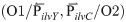
Schematic of the transcription regulation of the ilvY and ilvC genes.IlvY is the LysR-type transcriptional regulator designated in yellow. IlvY binds in a highly cooperative fashion to two tandem operator regions, O1 and O2, in the divergently overlapping ilvYC regulatory region designated (O1/P⃐ilvY,P⃑ilvC/O2). Upon binding to the first operator region, O1, the IlvY regulator negatively autoregulates transcription from the ilvY promoter, thus repressing its own further synthesis. Activation of ilvC transcription requires binding of the IlvY regulator to the second operator region, O2, and additional binding of a co-inducer such as 2-acetolactate (AL) or 2-aceto-2-hydroxybutanoate (AHB) to a preformed IlvY/O2 complex. When a co-inducer (red oval) is bound, a conformational change in the protein/DNA complex remodels the -35 region of the ilvC promoter and drastically increases the RNA polymerase binding capacity (Rhee et al., 1998). PilvC indicates the promoter of the ilvC gene. PilvY indicates the promoter of the ilvY gene. The minus sign (-) indicates a negative influence on gene transcription, and the plus sign (+) indicates a positive influence on gene transcription.